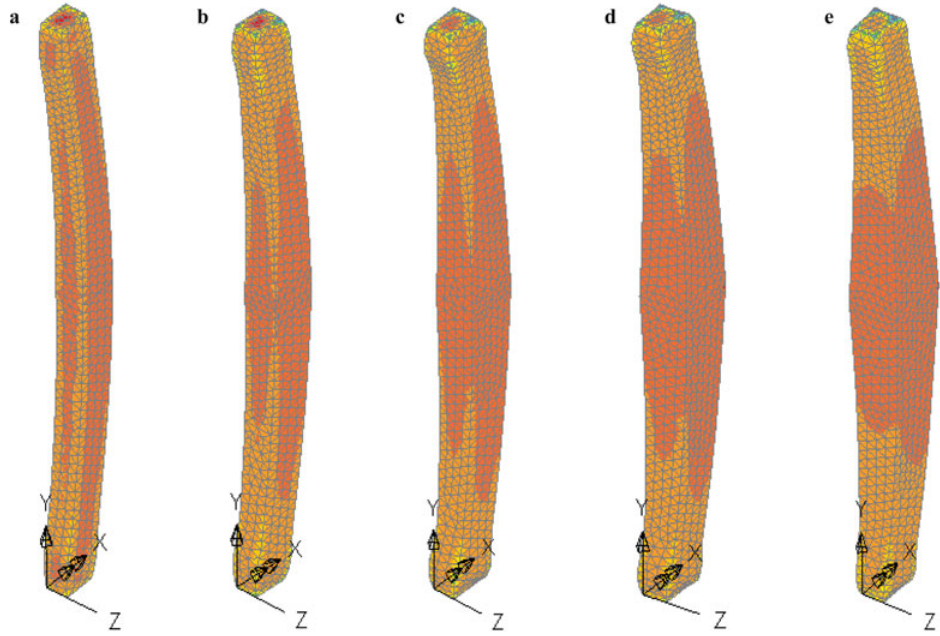
Fig. 12. Typical failure modes of the TCFSC columns: (a) u (cid:4) 0.55 8 , (b) u (cid:4) 1.10 8 , (c) u (cid:4) 1.65 8 , (d) u (cid:4) 2.20 8 , (e) u (cid:4) 2.75